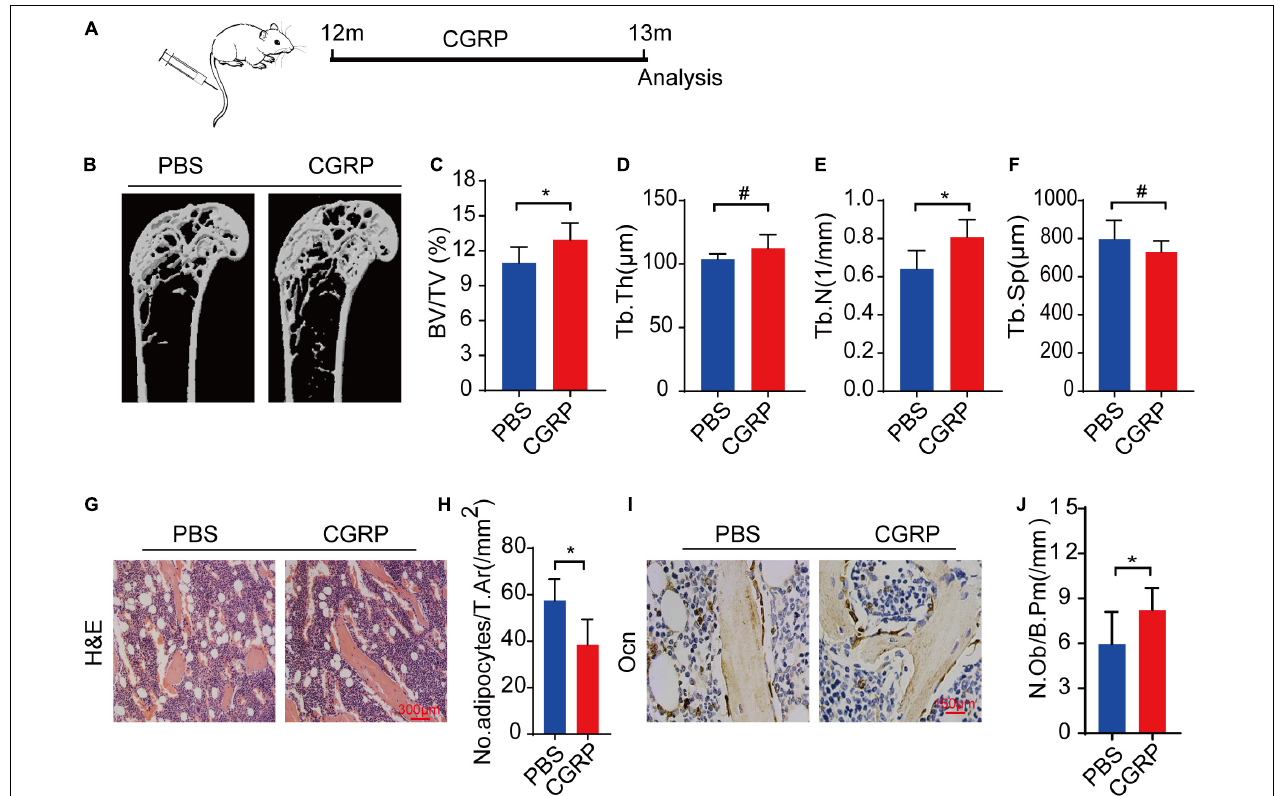
FIGURE 4 | CGRP treatment promoted bone formation in aged mice. (A) A schematic representation of the injection protocol (CGRP or 1 × PBS via the tail vein) in aged mice. (B) Representative micro-computed tomographs ( n = 6/group) and (C–F) quantitative analysis of bone volume as a fraction of total bone volume (BV/TV), trabecular thickness (Tb. Th), trabecular number (Tb. N), and trabecular separation (Tb. Sp) of femora from CGRP-treated and control mice. (G) Representative images of hematoxylin and eosin staining and (H) quantitative analysis of the number and area of adipocytes in the bone marrow of CGRP-treated and control mice. (I) Representative images of osteocalcin (OCN) staining and (J) quantification of osteoblast bone surface density (N.Ob/B.Pm) in the femora of CGRP-treated and control mice. Scale bars, 150 µ m. Data are presented as means ± SEM. * P < 0.05. # means no statistical significance.